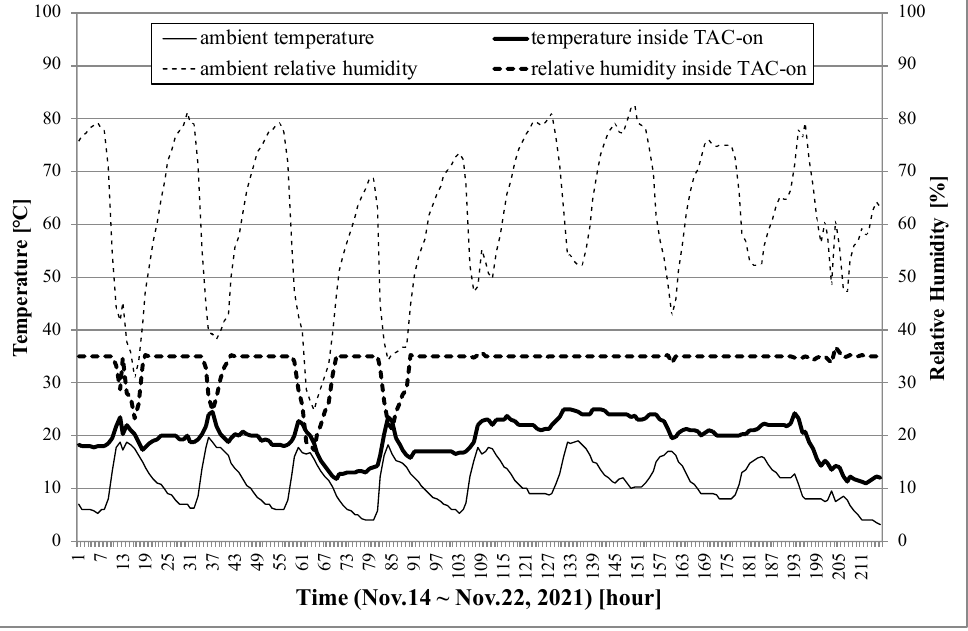
Figure 9. Comparison of temperature and relative humidity between inside and outside of TAC-on from 14–22 November